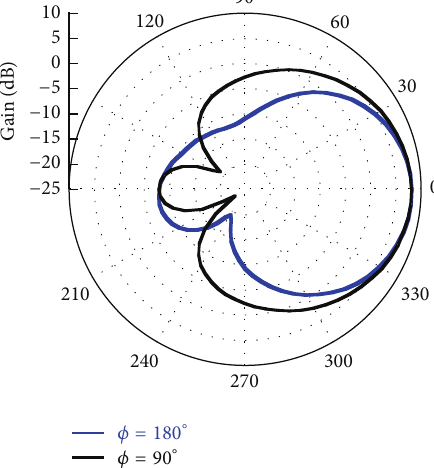
Figure 9: Return losses for different substrate thicknesses.